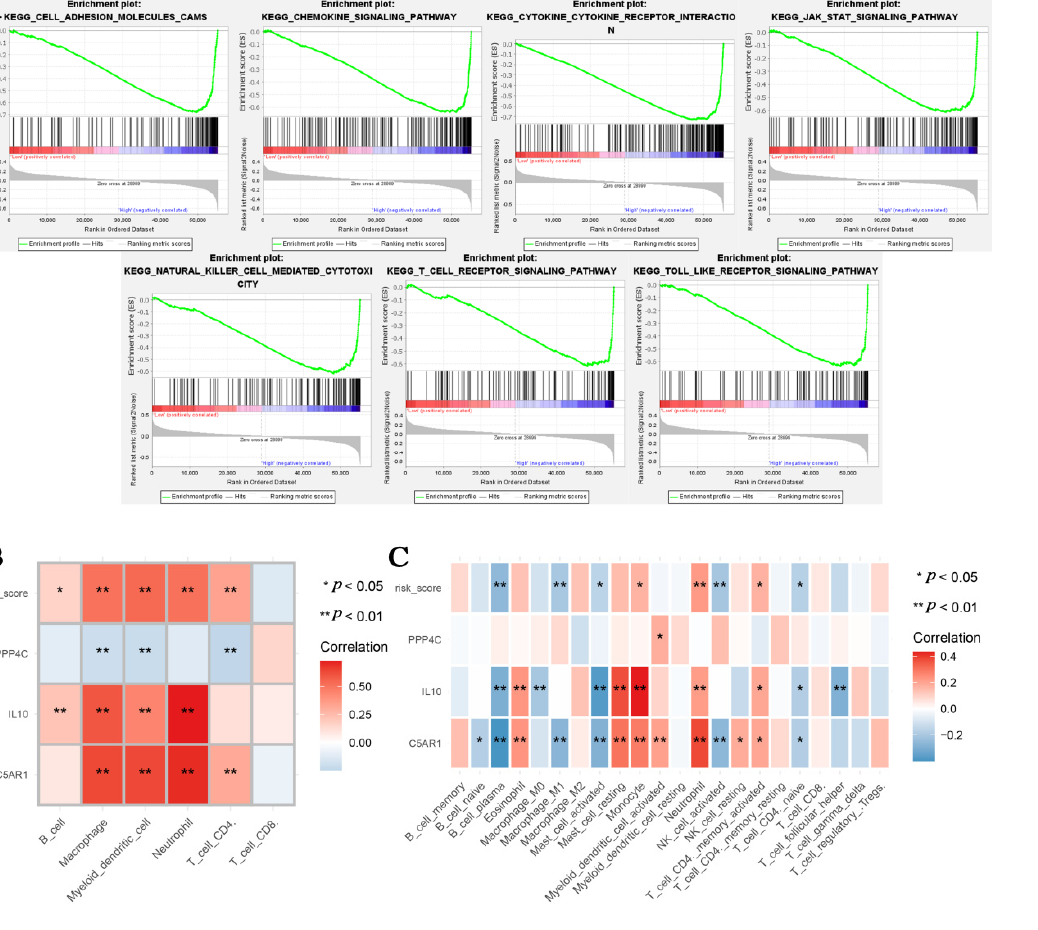
Figure 11. ( A ) Genome enrichment analysis (GSEA) of immune-related prognostic signature. ( B ) As- sociations between risk score and six types of immune cells found in TIMER. ( C ) Associations between risk score and 22 immune cell behaviors found in CIBERSORT. * p < 0.05,** p < 0.01.